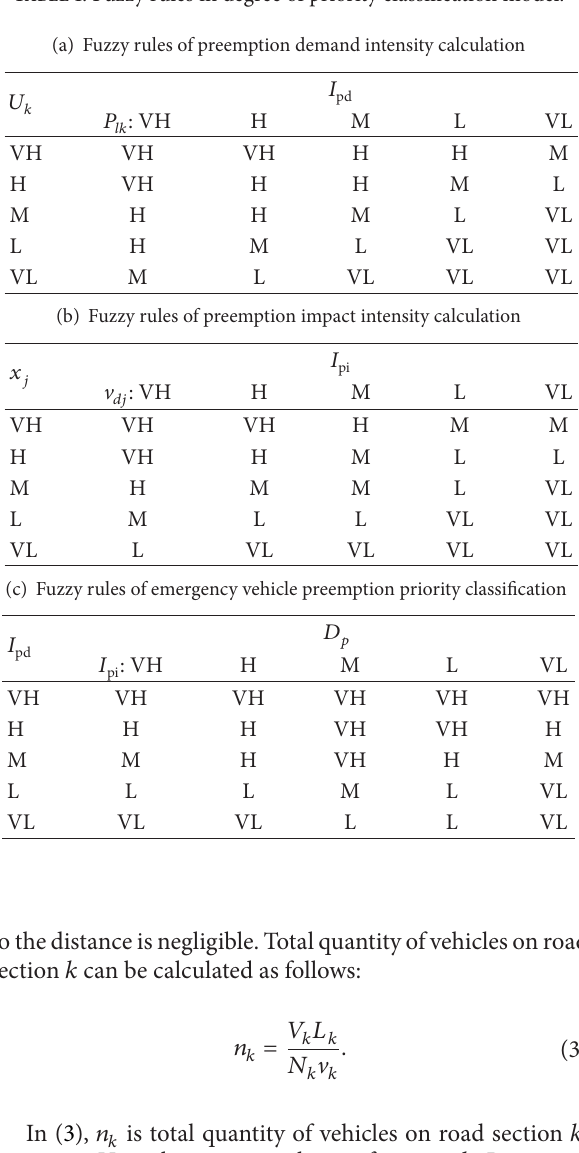
Table 1: Fuzzy rules in degree of priority classification